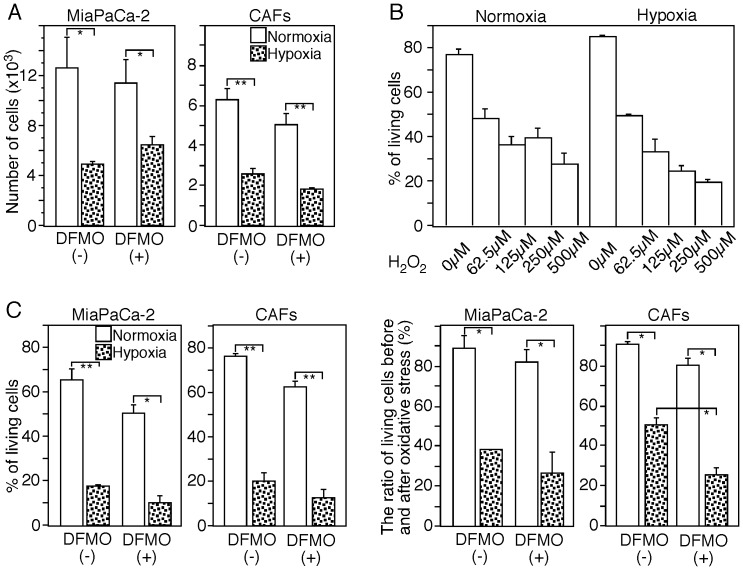
Pancreatic cancer cells and ARG2-expressing CAFs.(A) ARG2-expressing CAFs do not support proliferation of pancreatic cancer cells. CAFs extracted from PDC tissues and MiaPaCa-2 cells were co-cultured in medium with or without 2 mM DFMO under normoxic or hypoxic conditions for 48 hrs and the numbers of living cells were calculated the basis of data obtained by flow cytometry. The absolute number of MiaPaCa-2 cells cultured under hypoxic conditions decreased significantly in comparison with normoxic conditions, although this effect was not significantly affected by the presence of DFMO in the culture medium. Data represent one of three independent experiments. Significance value (Student’s t test) of P<0.05 (*) and P<0.01 (**). (B) Oxidative stress-induced apoptosis was induced in MiaPaCa-2 cells by exposure to various concentrations (0–500 µM) of H2O2 for 7 hrs. The dead cells and living cells were detected by flow cytometry after staining with Annexin V and PI. (C) ARG2-expressing CAFs did not protect pancreatic cancer cells from oxidative-induced apoptosis. After 48 hrs of co-culture of CAFs extracted from PDC tissues and MiaPaCa-2 cells in medium with or without 2 mM DFMO under normoxic or hypoxic conditions, all the cells were cultured for another 4 hrs under oxidative stress (50 µM H2O2) using the same conditions as before. The percentages of living cells were measured by flow cytometry (left column). In order to evaluate the effect of oxidative stress, the percentages of living cells after exposure to oxidative stress were divided by the percentages of living cells cultured under the same conditions before oxidative stress (right column). The ratio of living cells before and after oxidative stress decreased significantly in both MiaPaCa-2 cells and CAFs cultured under hypoxic conditions. Blocking the synthesis of polyamines with DFMO increased significantly the degree of oxidative stress-induced apoptosis in the CAFs. Data represent one of three independent experiments. Significance value (Student’s t test) of P<0.05 (*) and P<0.01 (**).